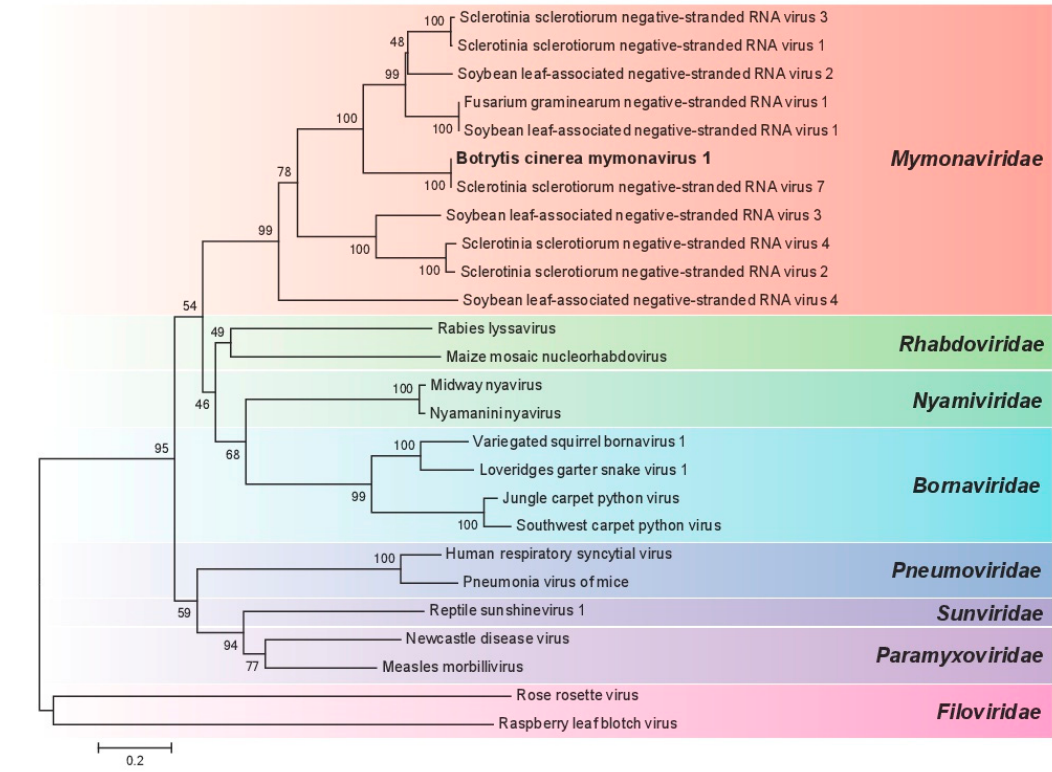
Figure 3. Phylogenetic analysis of Botrytis cinerea mymonavirus 1 (BcMyV1) based on RdRp domain from strain Ecan17-2 of B. cinerea .